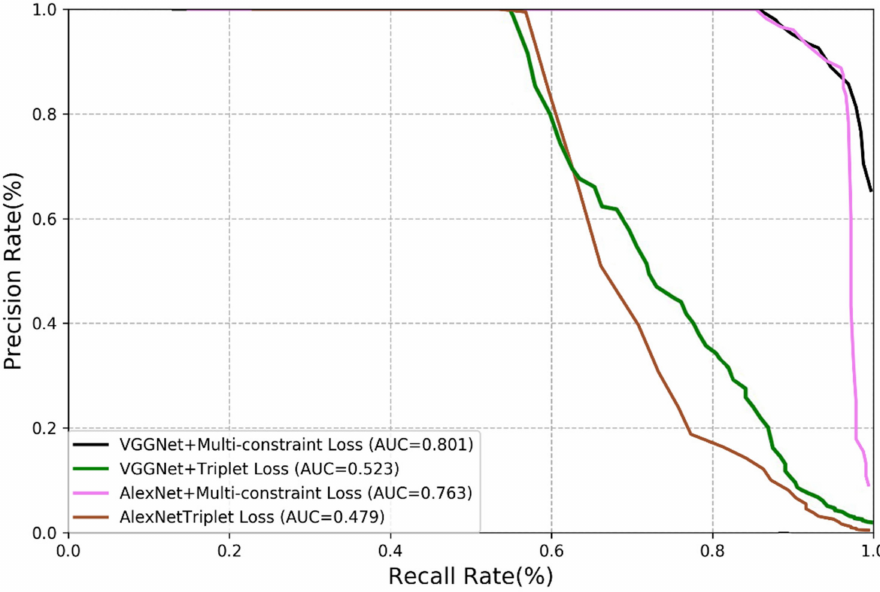
Figure 8. Comparison of multi-constraint loss and triplet loss (TUM